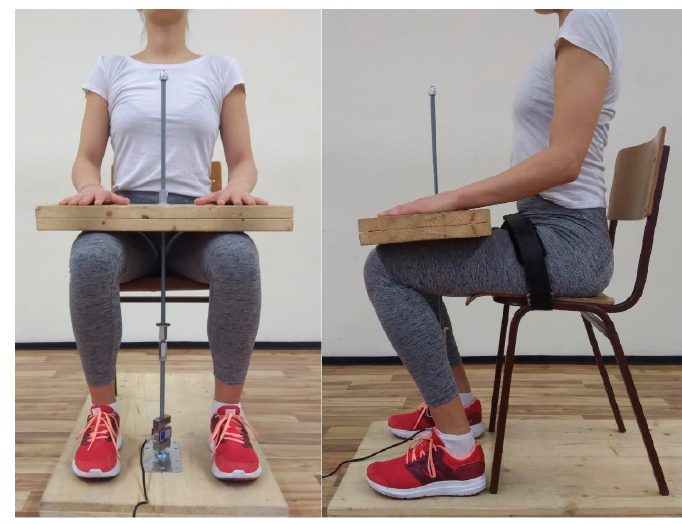
Figure 1. Isometric ankle extensors strength measurement procedure.